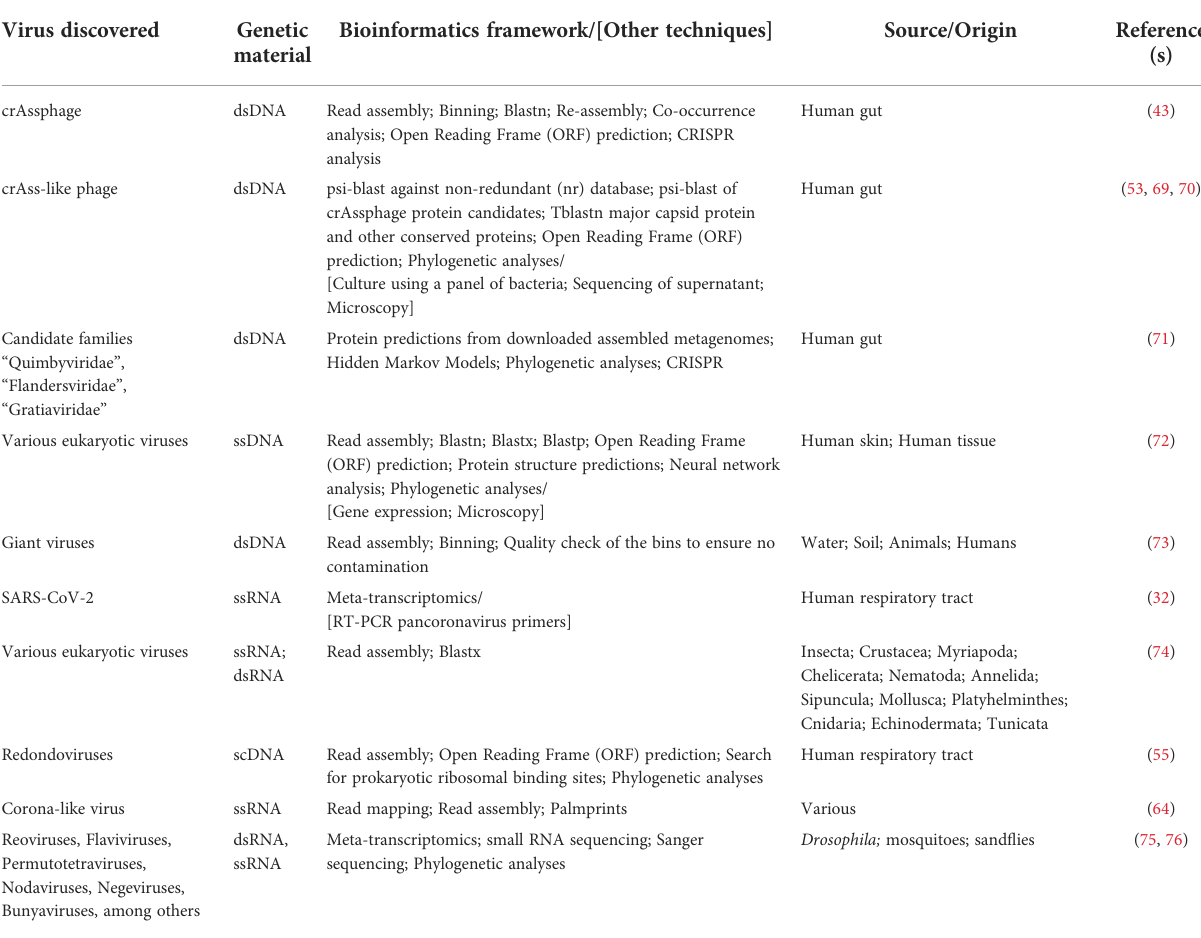
TABLE 2 Summary of bioinformatic tools used for virus